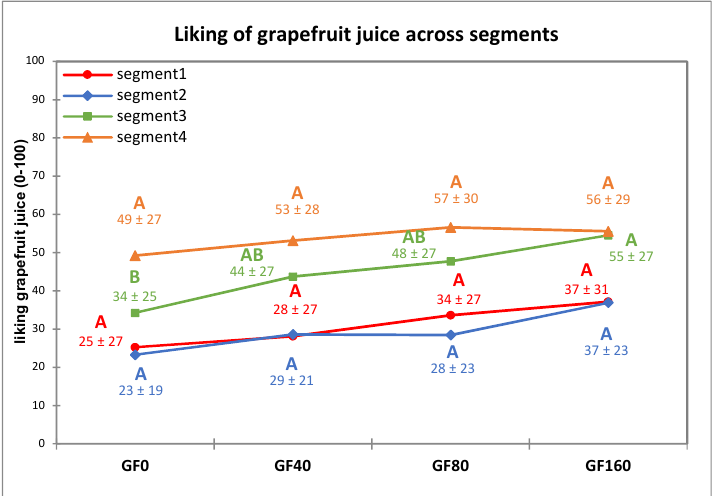
Figure 5. The effect of segment and sucrose concentration on liking for grapefruit juice (mean liking ± SD), (GF; 0–160 g/L added sucrose). Different letters indicate significant differences ( p < 0.05) from Tukey’s HSD test across concentrations within each segment.